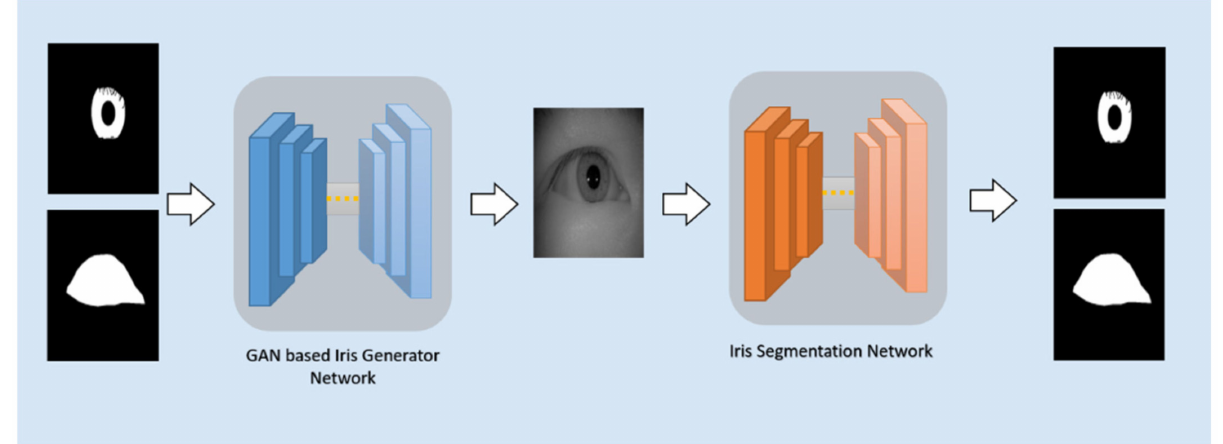
Figure 1. An overview of our